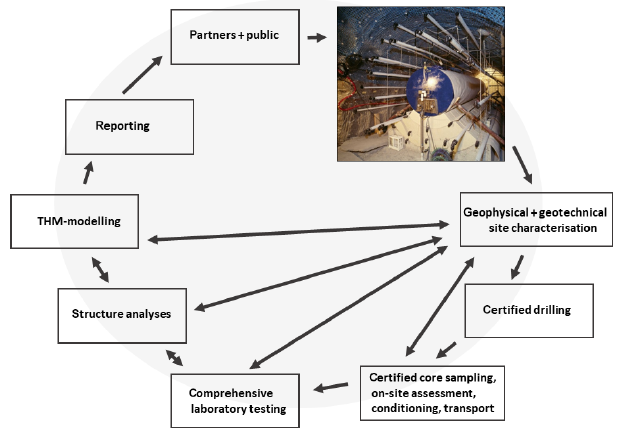
Figure 2. BGR’s involvement and contributions to the complete chain of experiments supporting the Mont Terri rock laboratory; in- cluded are the main dependencies to highlight the